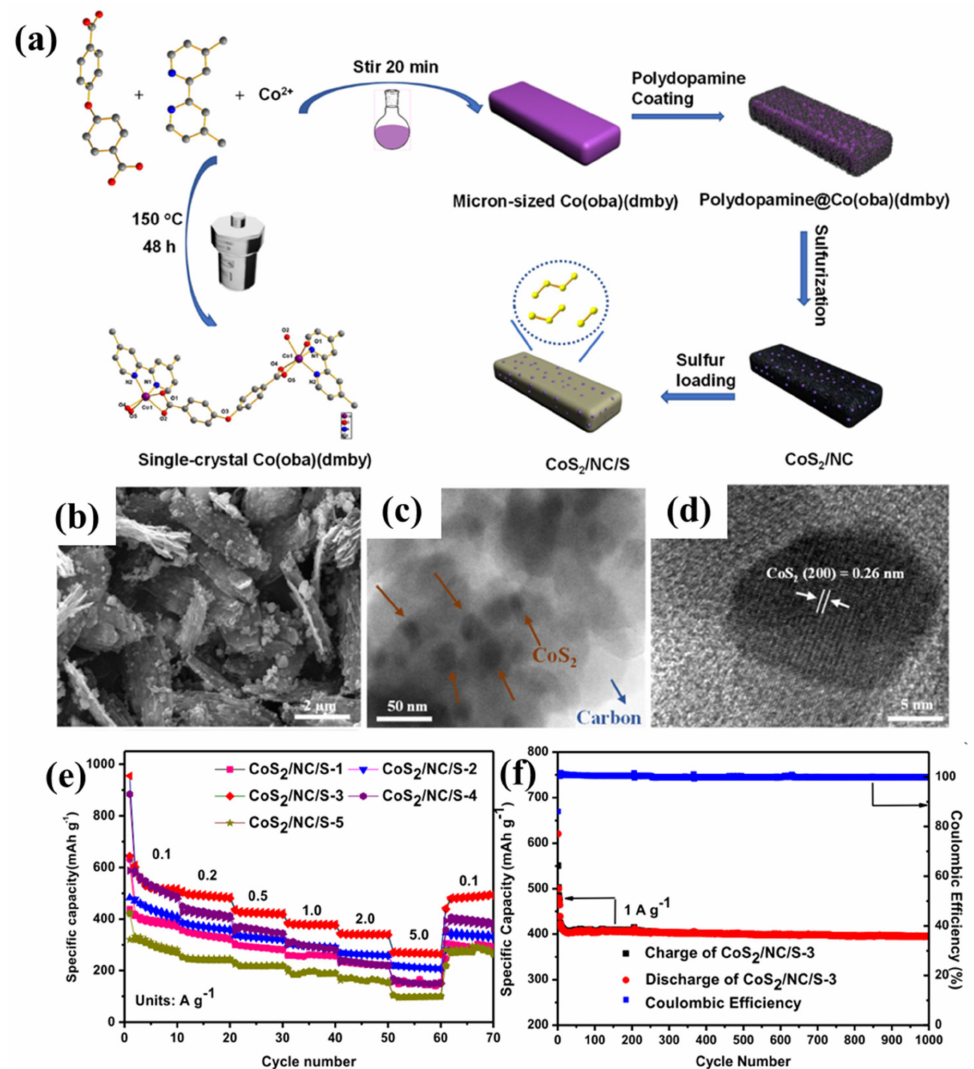
Figure 14. ( a ) Schematics of the CoS 2 /NC/S composite fabrication stages. ( b ) SEM picture of the composite CoS 2 /NC. ( c ) TEM pictures of the CoS 2 /NC composite, with red and blue arrows indicat- ing the locations of CoS 2 nanocrystals and the surrounding carbon matrix, respectively. ( d ) HRTEM picture of a single CoS 2 nanocrystal embedded in a CoS 2 /NC composite. ( e ) CoS 2 /NC/S-x elec- trode rate performance. ( f ) 1 A/g long-term cycling of the CoS 2 /NC/S-3 electrode. Adapted with permission [309]. Copyright (2021) American Chemical